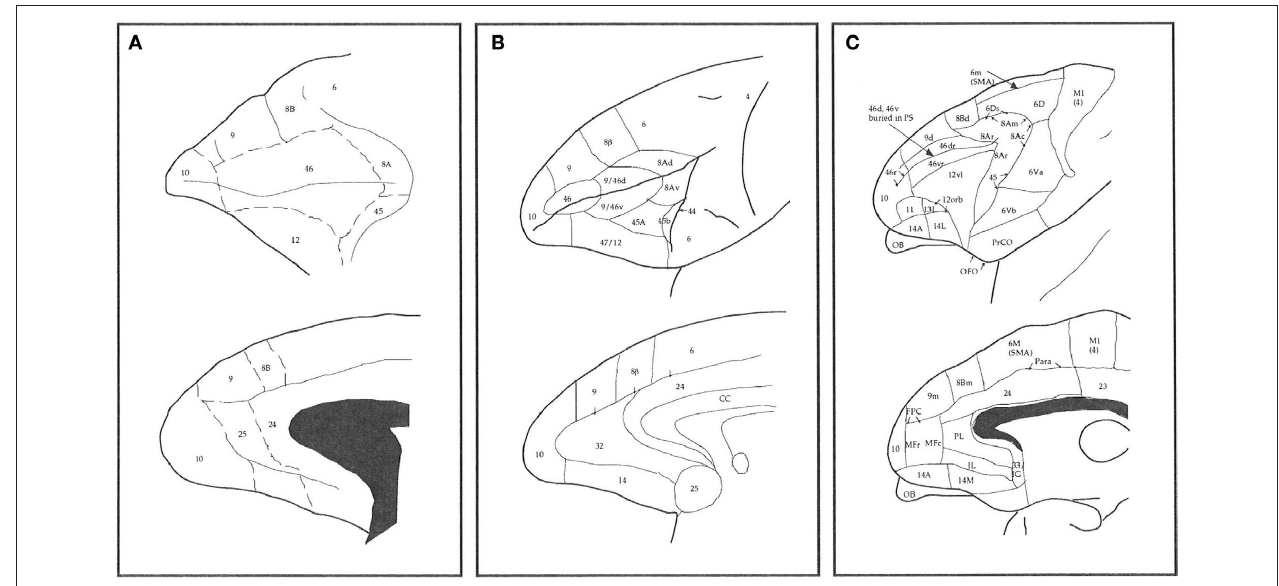
Figure 1 | Schematic illustrating some different interpretations of the number, size, and location of cortical areas in prefrontal cortex of the macaque monkey. (A) Modified from Walker (1940), (B) Petrides and Pandya (1999) and (C) Preuss and Goldman-Rakic